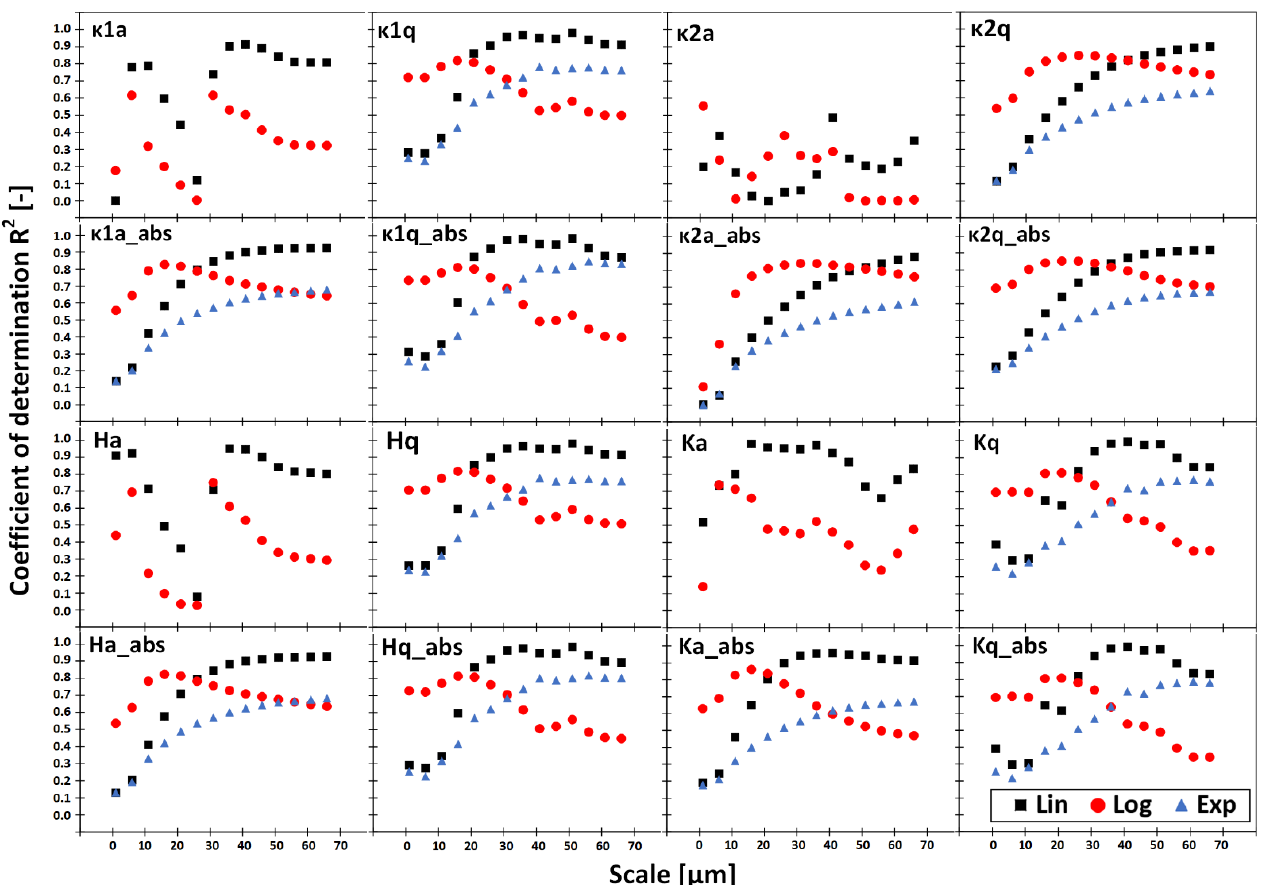
Figure 9. Coefficient of determination for linear, exponential, and logarithmic regression plotted as a function for all analyzed curvature